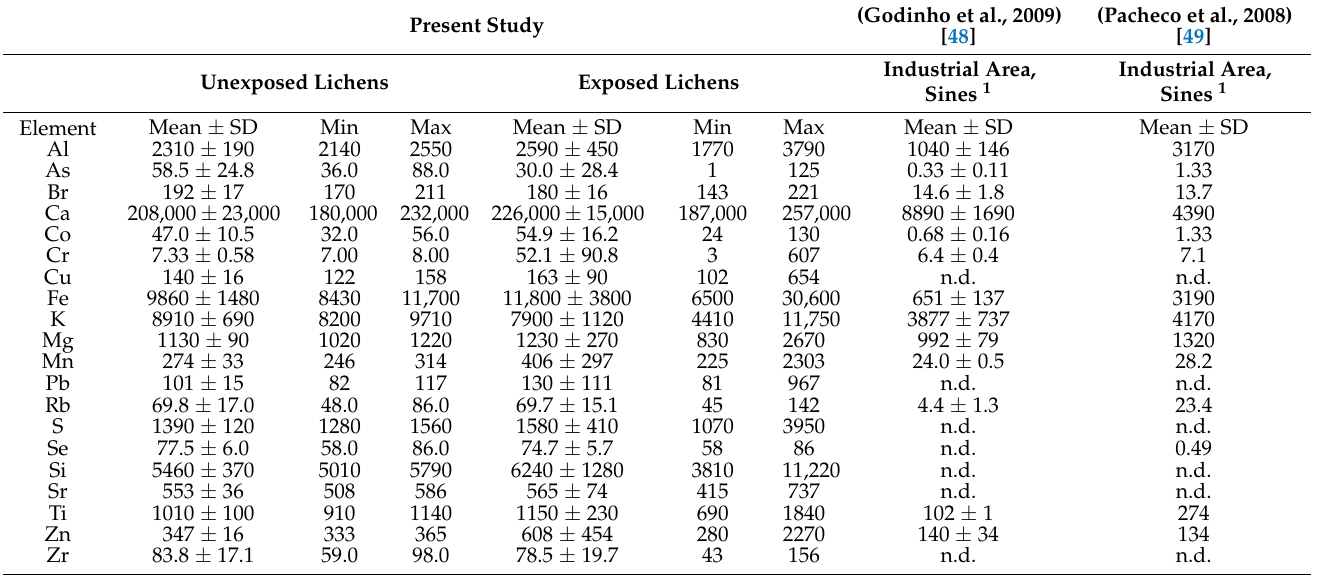
Table 1. Mean elemental mass fractions (in mg · Kg − 1 , dry weight) in unexposed and exposed lichens samples and comparison with values from other